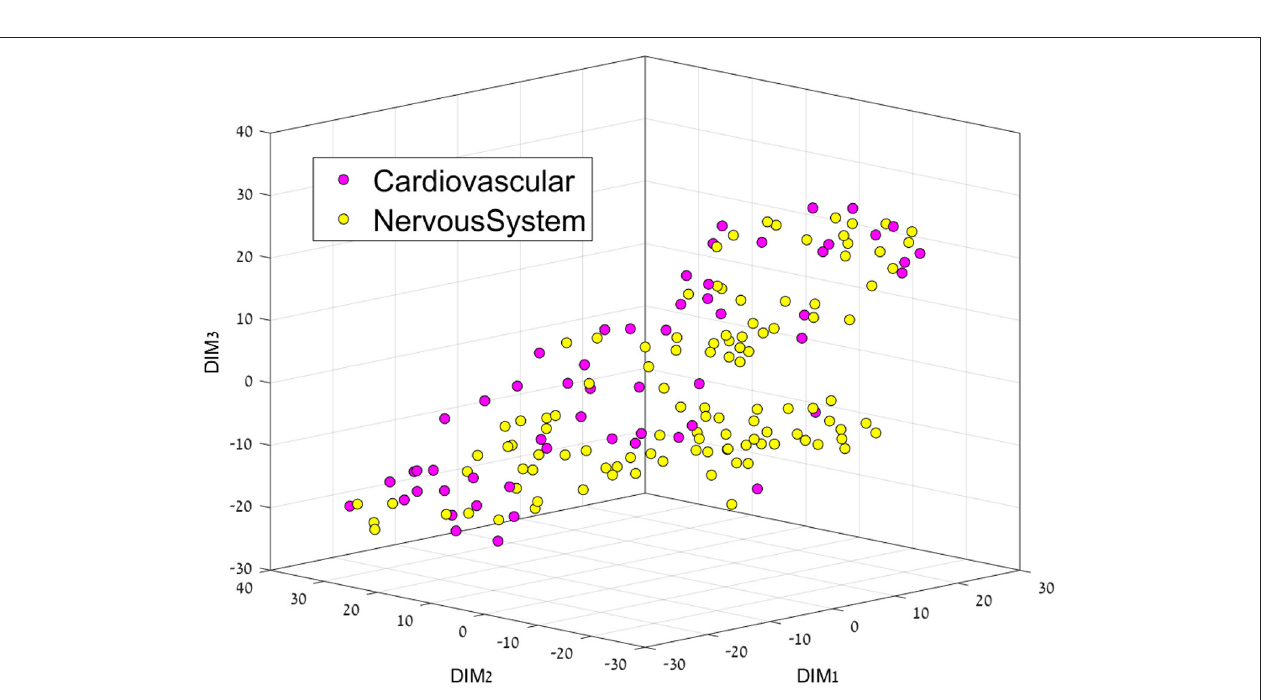
values are better when compared to those obtained previously using naïve Bayesian classifiers for the same data sets, 0.88 for training set, and 0.90 for the test set (García-Sosa and Maran, 2013). The sensitivity for the AL Boost method was much higher than using Bayesian classifiers, of 0.89 and